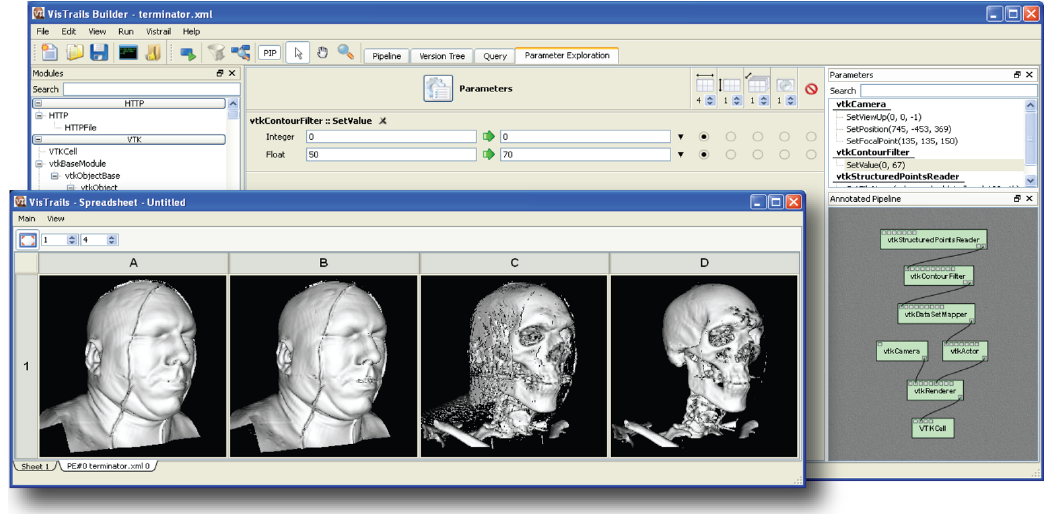
Figure 5. A provenance report from Vistrails that show data generated at each step of the workflow for a particular parameter setting.